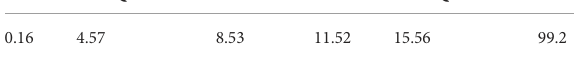
TABLE 2 Summary of time (in seconds) required to process a whole CT study.